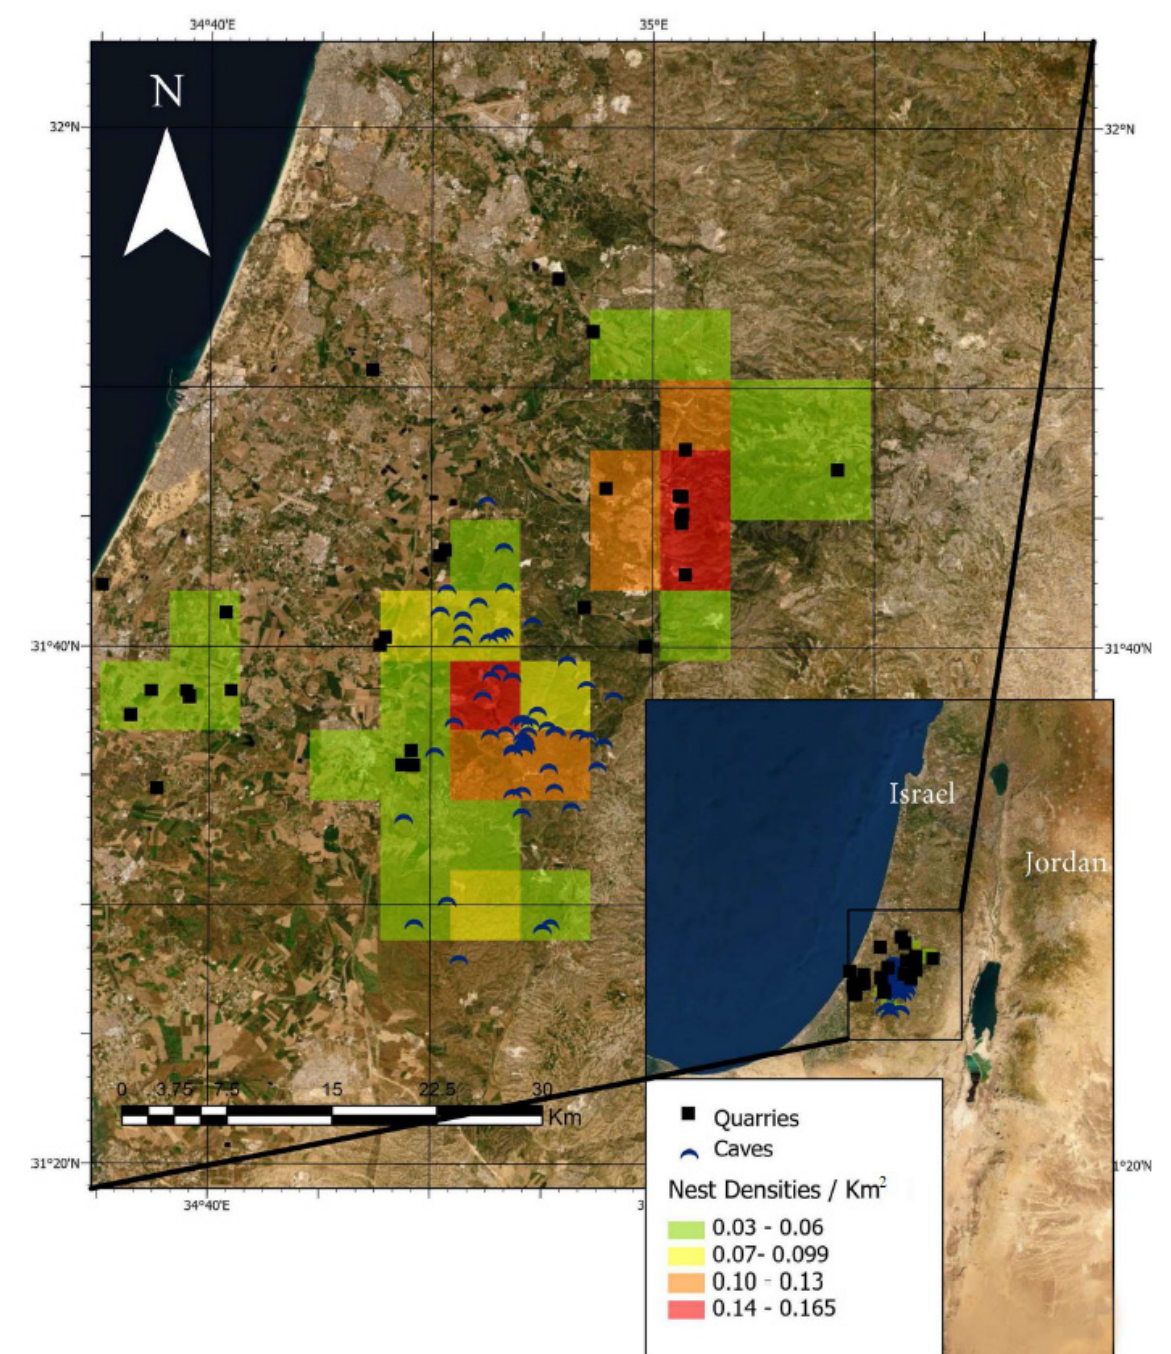
Figure 1. Map of the study site, the Judea region, in central Israel. The black squares denote the locations of all the quarries including those not occupied, the elliptical line denotes the bell caves and the colored blocks the relative densities of eagle owl ( Bubo bubo ) nest sites. The inset map shows the study area in relation to the region; each grid is 15 km 2 . Not all the quarries and caves were occupied.